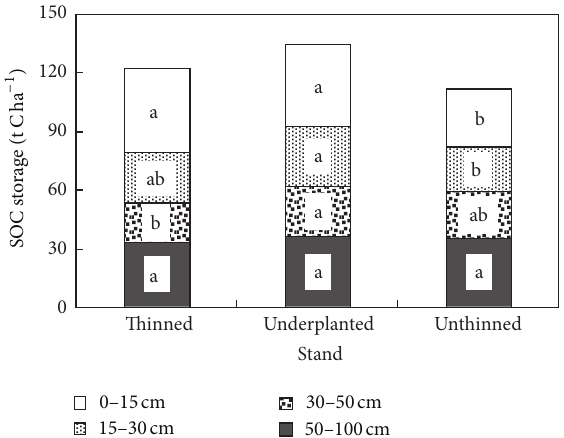
Figure 2: SOC storage (tCha −1 ) in the 0–15cm, 15–30 cm, 30– 50 cm, and 50–100 cm soil layers in the thinned, underplanted, and unthinned treatments; different letters in the same soil layer indicate there are significant differences among the three treatments (5% level, Duncan’s test).